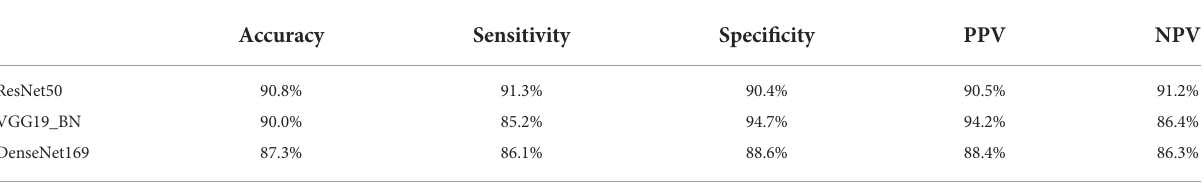
TABLE 2 The diagnostic performance of the three convolutional neural network (CNN)